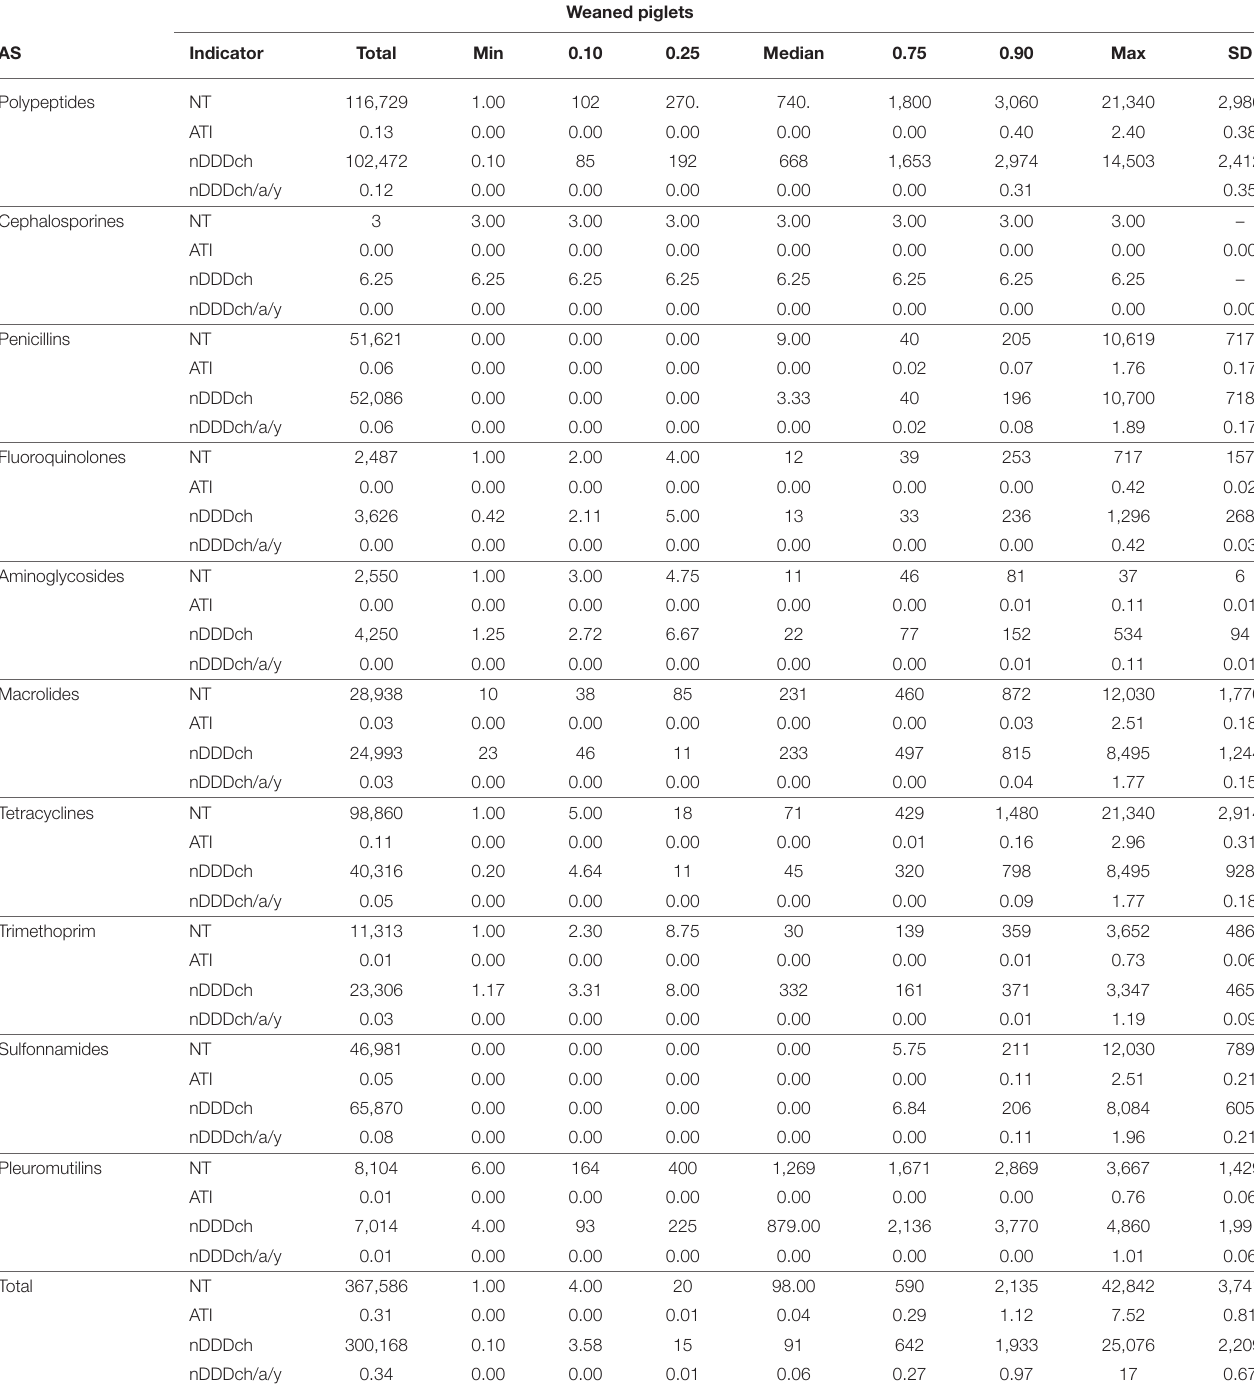
TABLE 3 | Total, minimum (min), median, maximum (max), 10% (0.1), 25% (0.25), 75% (0.75), 90% (0.9) percentiles and standard deviation (SD) of AMU in weaned piglets of the study farms measured using the indicators NT, ATI, nDDDch, and nDDDch/animal/year (nDDDch/a/y) displayed by active substance